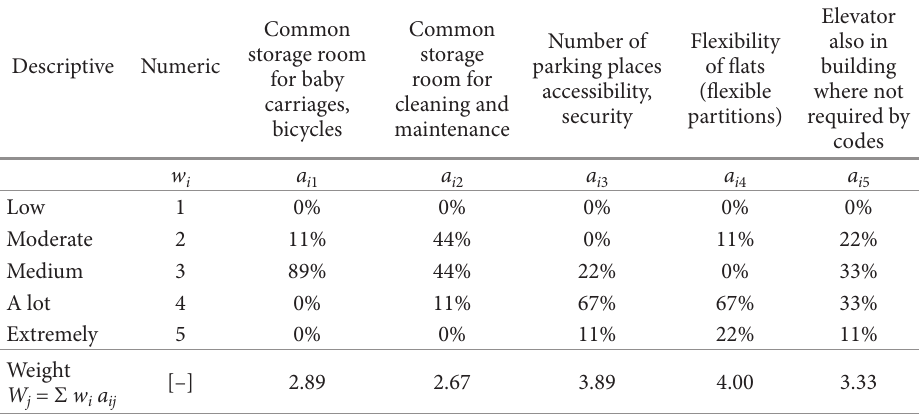
Importance of element